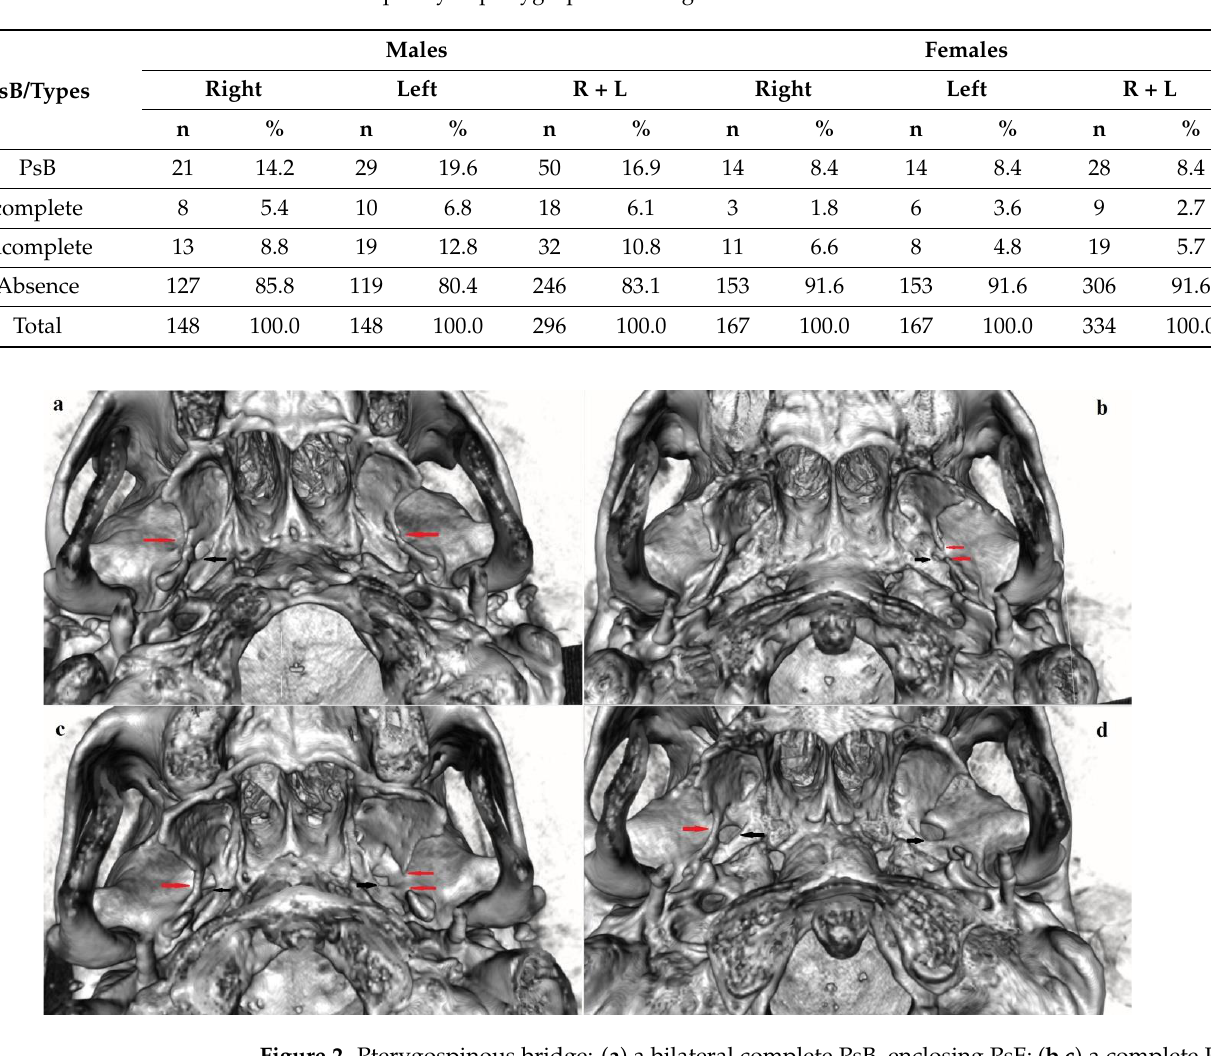
Figure 3. Pterygoalar bridge: ( a ) a bilateral complete PaB, enclosing PaF; ( b ) a complete PaB on the right side and an in complete PaB on the left side; ( c ) a unilateral (right - sided) complete PaB; ( d ) an incomplete PsB on the right side and a complete PaB on the left side. Designations: red arrows point to PsBs; black arrows point to foramen ovale. Abbreviation: PaB—pterygoalar bridge, PaF—pterygoalar foramen, PsB—pterygospinous bridge.